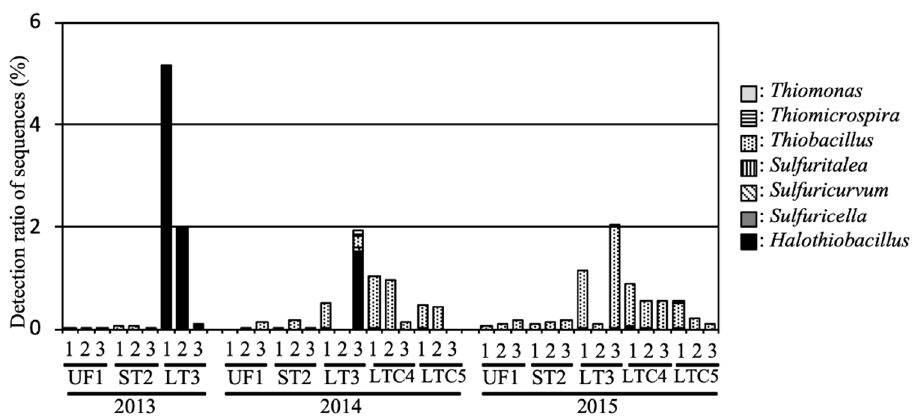
Figure 5. Relative abundance of sulfur-oxidizing bacteria (SOB) in the soil samples.